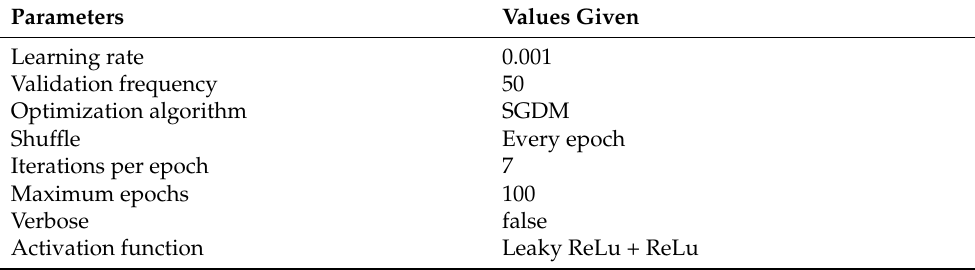
Table 4. Parameters used for